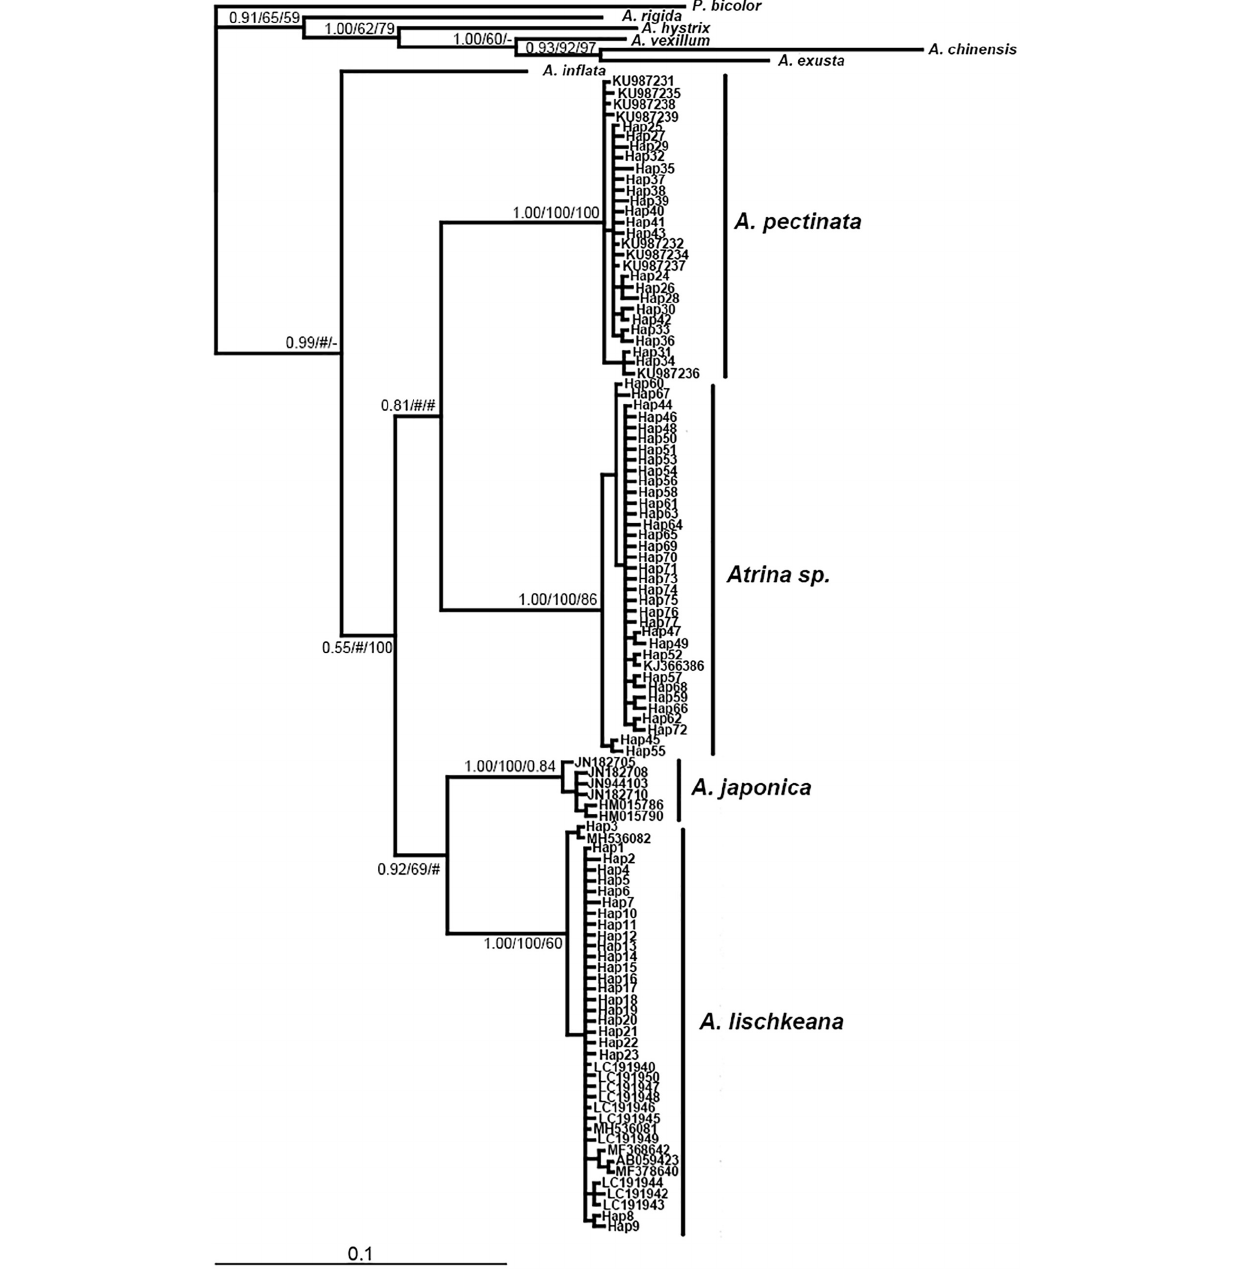
FIGURE 4 | Bayesian tree of mt COI showing the phylogenetic placement of the four species in the A. pectinata species complex. The numbers at the nodes represent the Bayesian inference posterior probabilities, neighbor-joining, and maximum likelihood probability